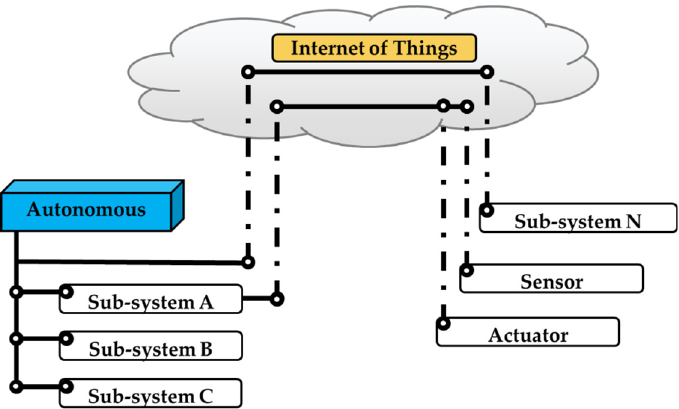
Figure 4. How IoT extends an Autonomous System.